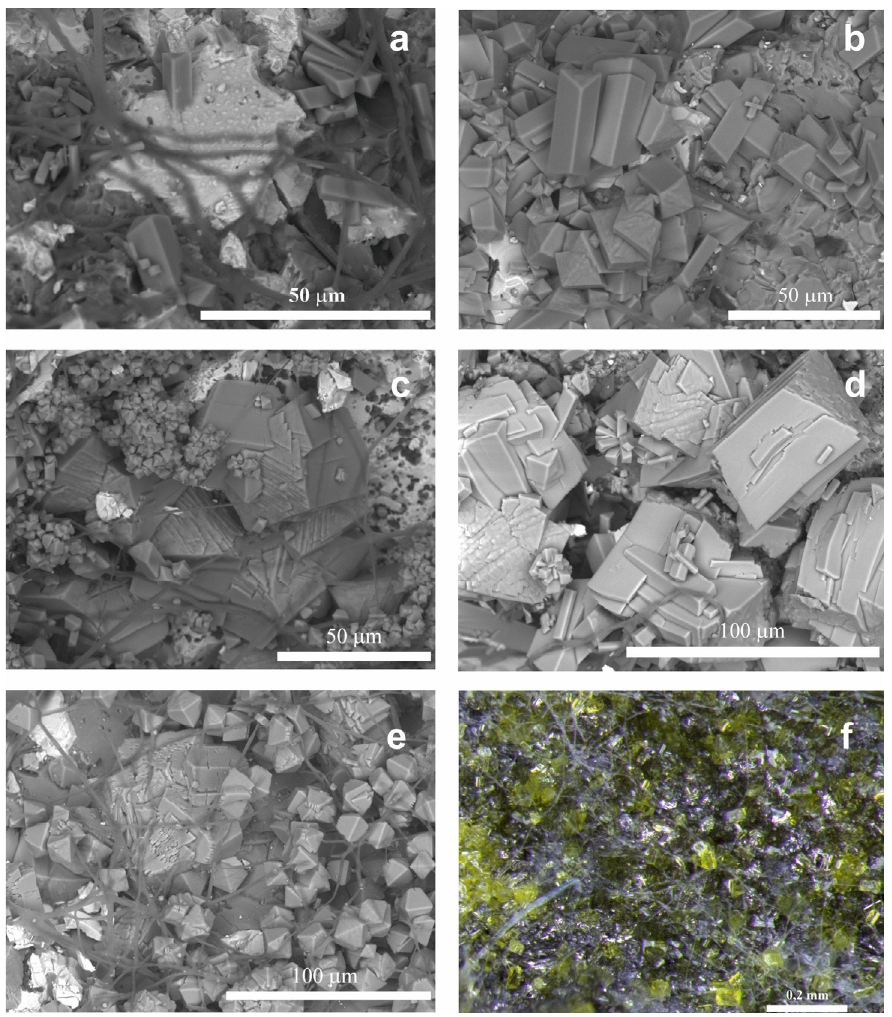
Figure 3. Formation of humboldtine crystals under the action of A. niger on the pyrrhotite surface: a —SEM image on the 3rd day, b —SEM image on the 7th day, c —SEM image on the 10th day, d — SEM image on the 14th day, e —SEM image on the 18th day, f —under a light microscope on the 18th day.